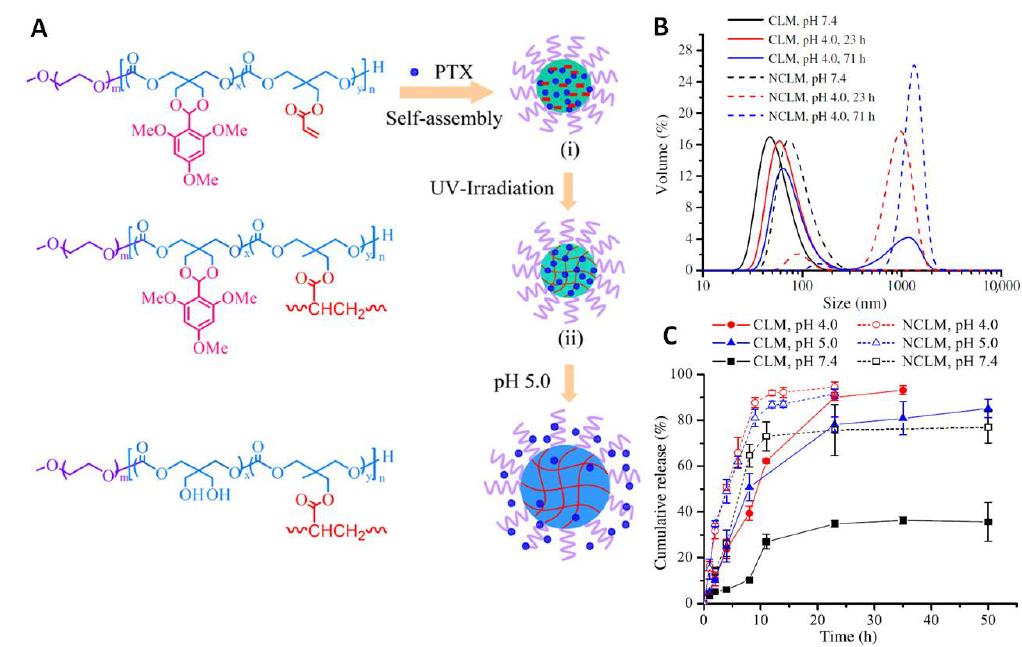
Figure 2. ( A ) Schematic illustration of photo-crosslinkable pH-responsive micelles based on poly(ethylene glycol)-poly(2,4,6-trimethoxybenzylidene-pentaerythritol carbonate- co -acryloyl carbonate) diblock copolymer. PTX-loaded crosslinked micelles exhibit superior extracellular stability while “actively” release PTX under a mildly acidic condition mimicking that of the endo / lysosomal compartments. ( B ) Size change of pH-sensitive crosslinked (CLM) and non-crosslinked (NCLM) micelles at various pH and 37 ◦ C determined by dynamic light scattering measurements (DLS). ( C ) pH-dependent drug release from PTX-loaded crosslinked and non-crosslinked micelles at 37 ◦ C. Reprinted with permission from ref [73]. Copyright 2012 Elsevier